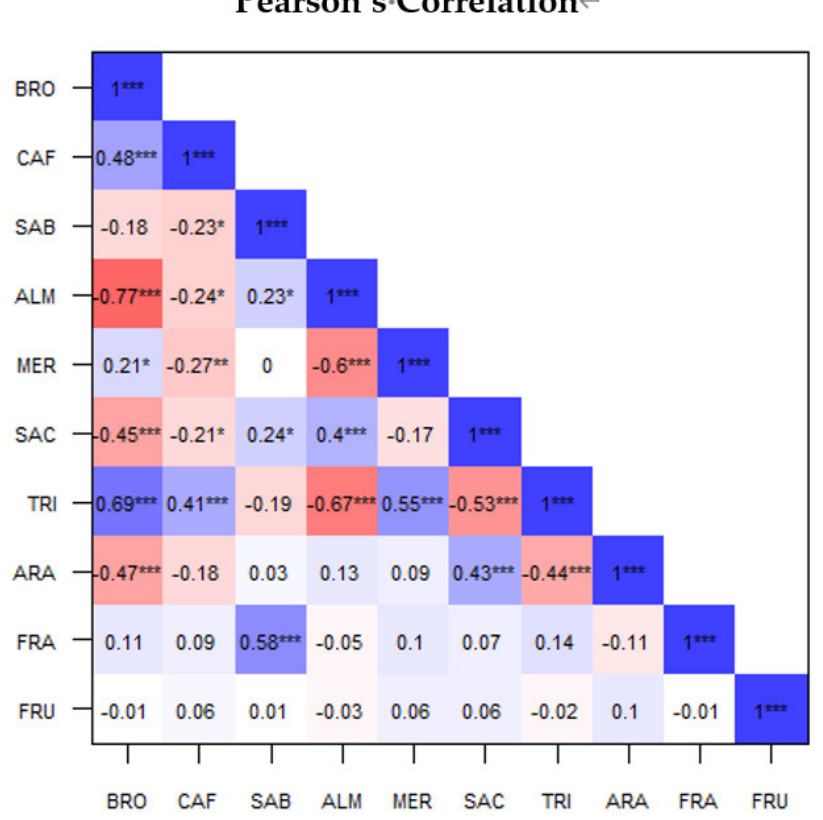
Figure 7. Heatmap of quality variables correlated with the total SCA score. Significant codes: 0 ‘***’ 0.001 ‘**’ 0.01 ‘*’ 0.05.